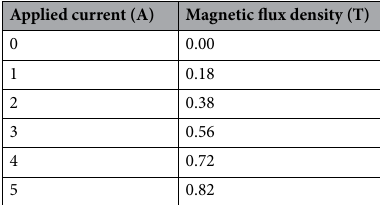
Table 3. The relationship between applied current and magnetic flux